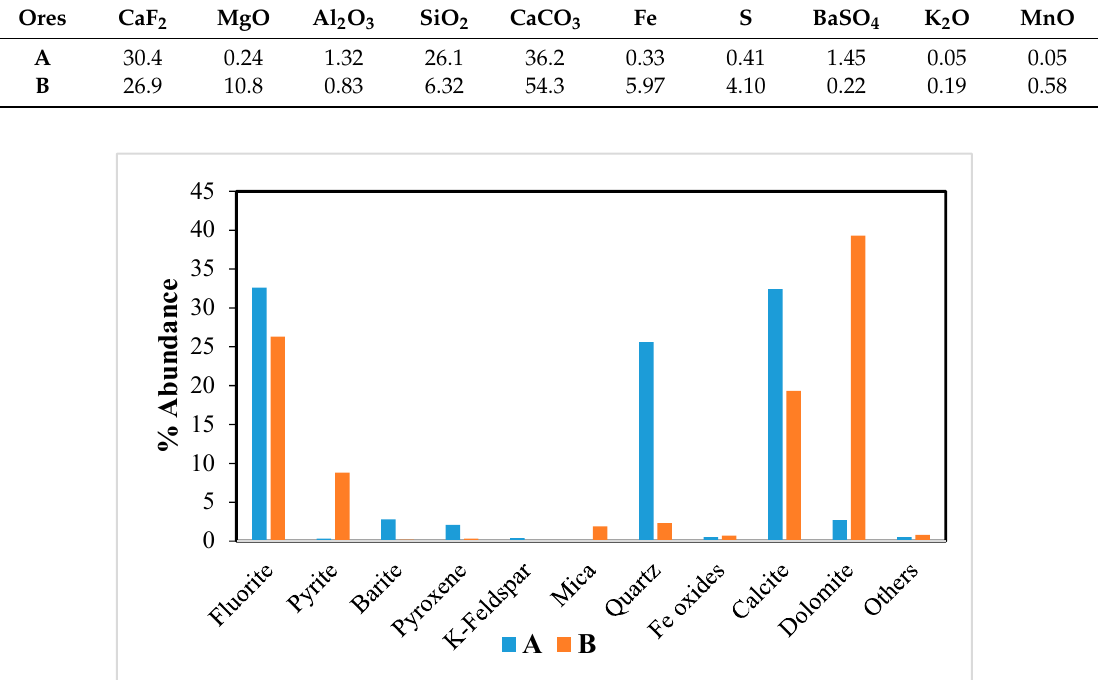
Figure 1. Bulk mineralogical analysis of fluorspar ores A and B in mass %.